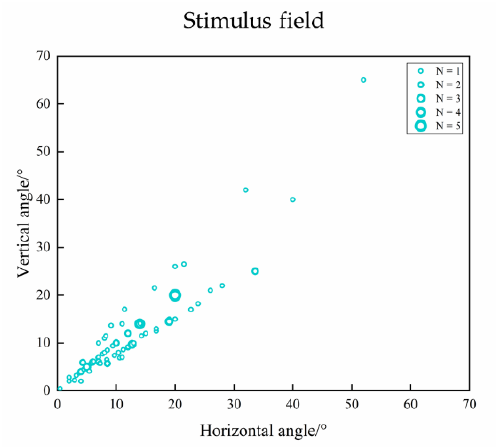
Figure 7. Visual angle of stimulus field in selected studies of VEP acuity assessment.